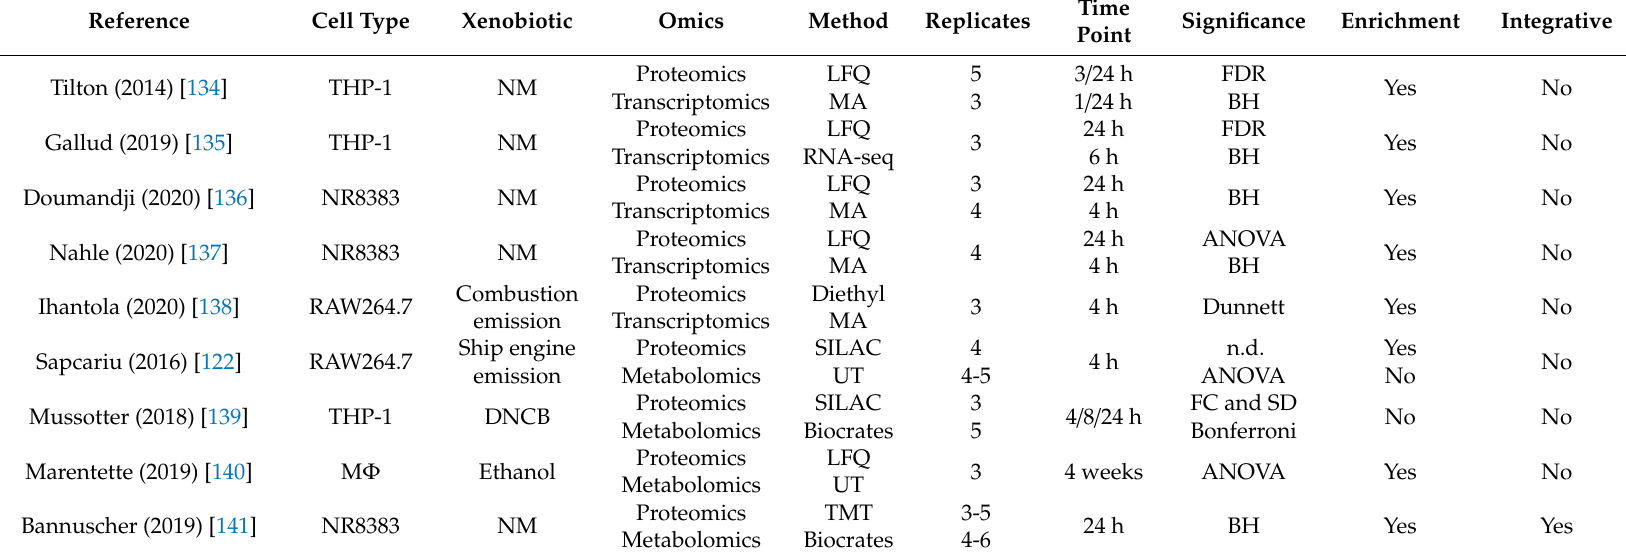
Table 1. Summary of the reviewed publications. Summarized are the used cell types (M Φ : Macrophages), the investigated xenobiotics, the applied omics approaches, the used method, the number of replicates, the investigated time points, the method to correct for multiple testing (Significance, n.d.: not defined), if enrichment analyses were conducted, and whether these were performed integratively. NM—nanomaterial; DNCB—2,4-dinitrochlorobenzene; UT—untargeted; Biocrates—use of one of the kits available from Biocrates; LFQ—label-free quantification; TMT—tandem mass tags; Diethyl—diethyl labeling; SILAC—stable isotope labeling by amino acids in cell culture; MA—microarrays; FDR—adjustment of p-values using false discovery rates; BH— p -value adjustment according to Benjamini &